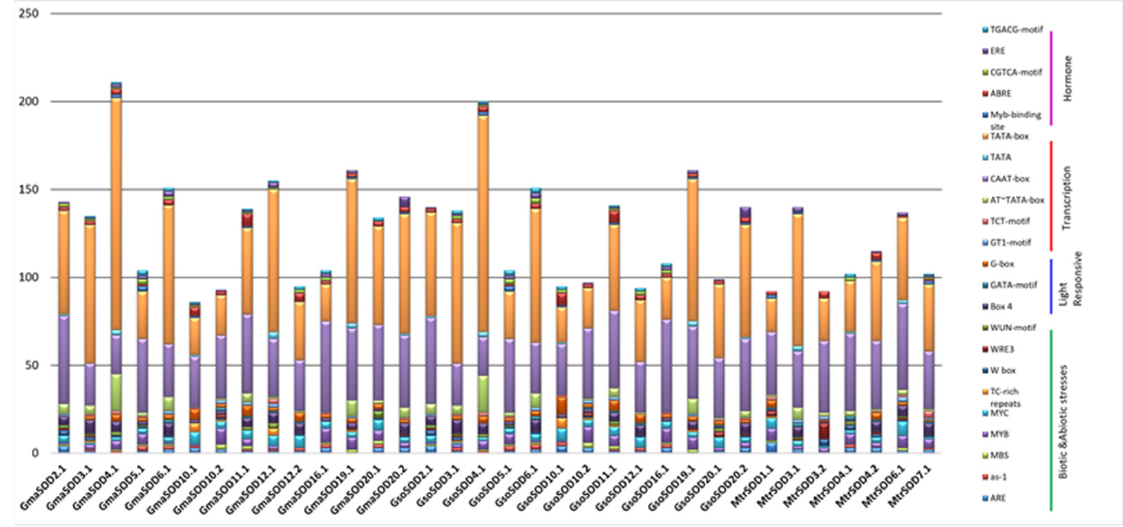
Figure 5. An overview of cis-regulatory elements in SOD family members of G. max and G. soja.